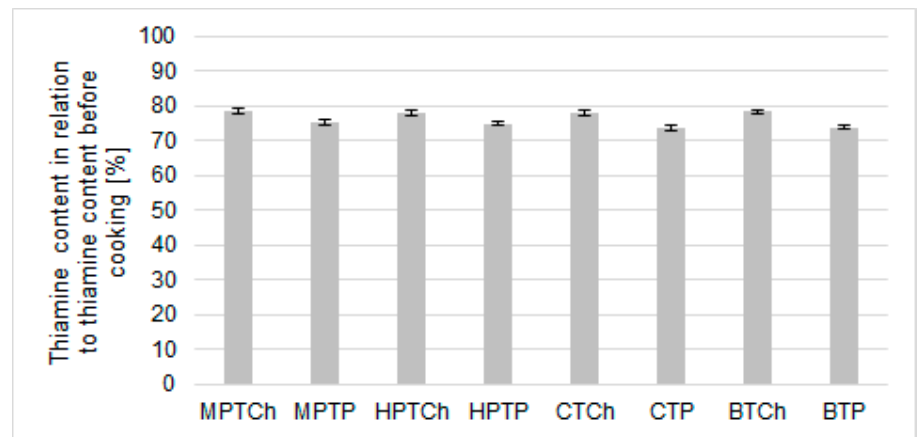
Figure 2. Thiamine content [%] after thermal processing (100 °C/5 min) of gnocchi dumplings with thiamine hydrochloride (TCh) and thiamine pyrophosphate (TP) sources (Muscat Pumpkin—MP, Hokkaido Pumpkin—HP, Cauliflower—C and Broccoli—B) .